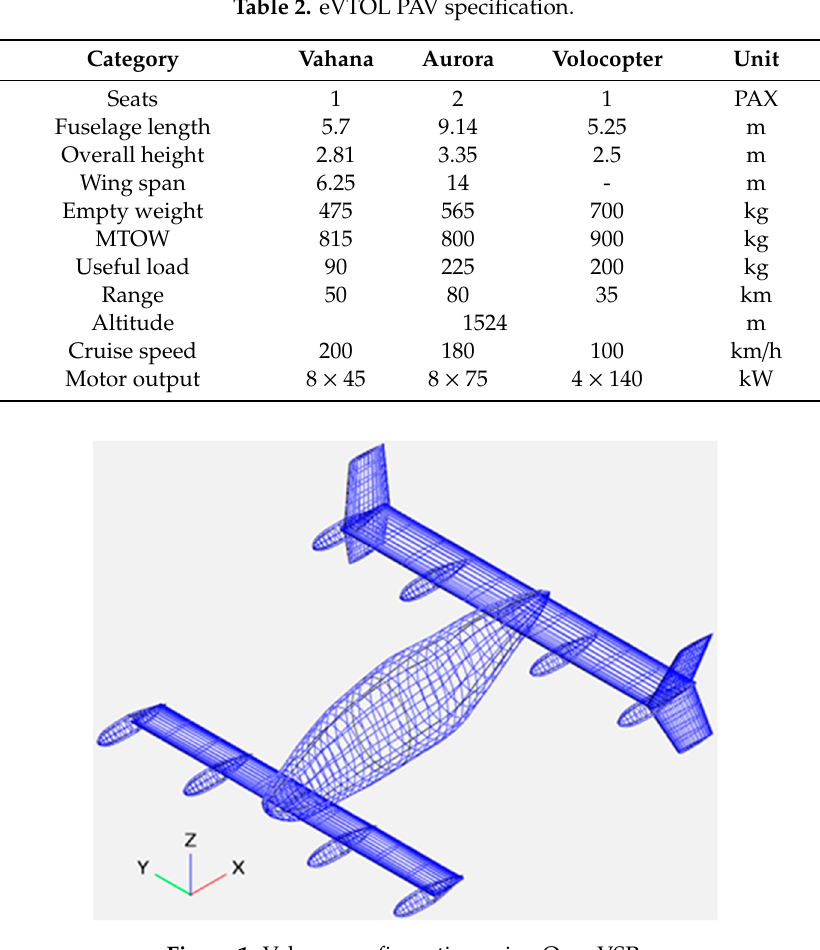
Table 3. Specifications of the 2170 battery cell.